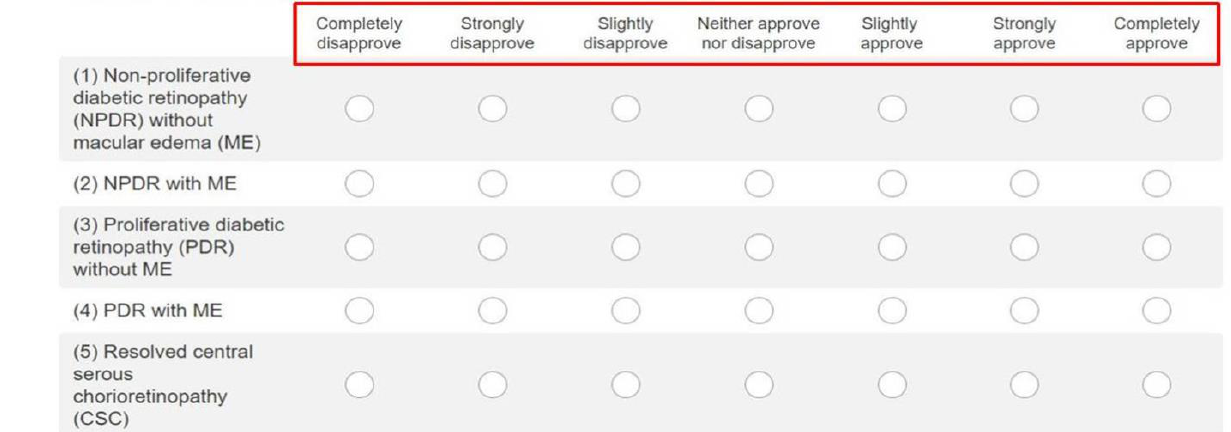
Figure 1. ( A ) The overview for the survey on SurveyMonkey. The introductory summary